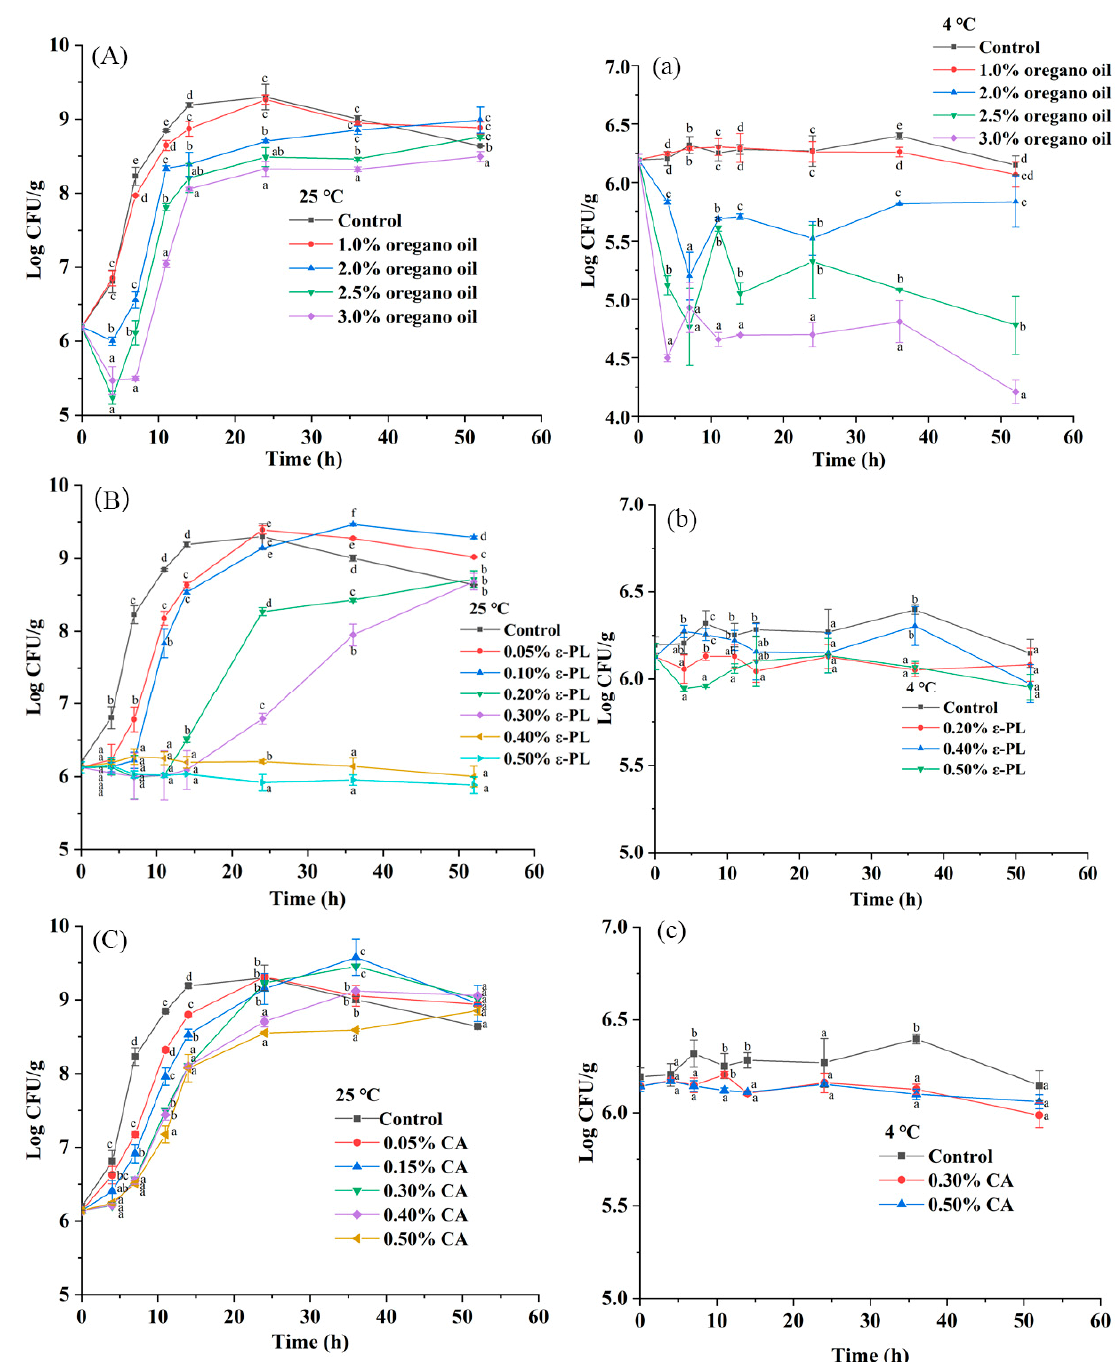
Figure 5. Antimicrobial activity of oregano oil, ε -PL and CA against S . Montevideo CICC21588 in diluted tahini at 25 °C ( A – C ) or 4 °C ( a – c ). The same lower case letter among different treated samples at each day during storage indicates mean values that are not significantly different ( p > 0.05).